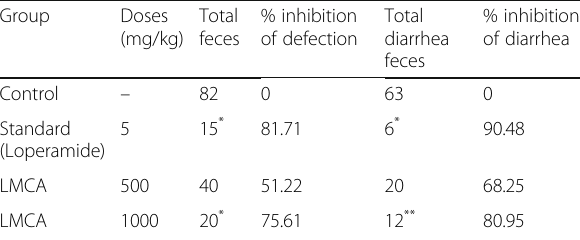
Table 9 Effect of LMCA in magnesium sulphate